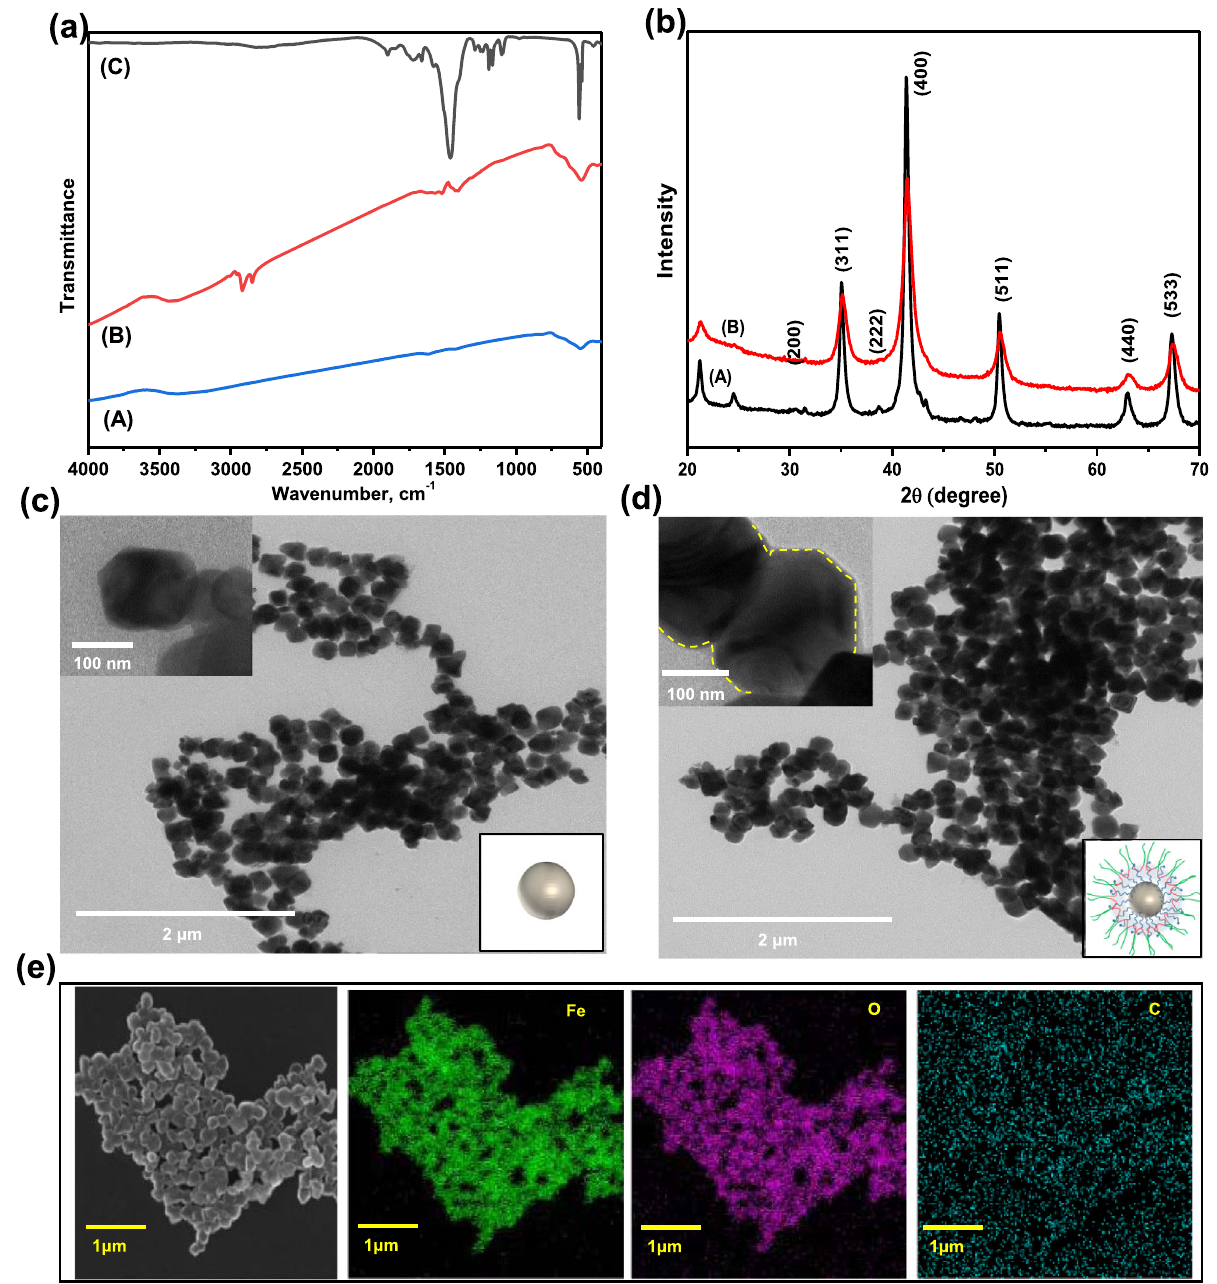
Fig. 2 Structural and morphological characterizations of TM nanorobots. (a) FTIR spectra of pristine Fe 3 O 4 nanoparticles (A), oleic acid-functionalized Fe 3 O 4 nanoparticles (B), and TM nanorobots (C) in the range of 4000 – 400cm − 1 . ( b) XRD pattern of pristine Fe 3 O 4 nanoparticles (A) and TM nanorobots (B). TEM images of ( c ) pristine Fe 3 O 4 nanoparticles and ( d ) TM nanorobots (inset shows magni fi ed TEM images), ( e ) EDS mapping of TM